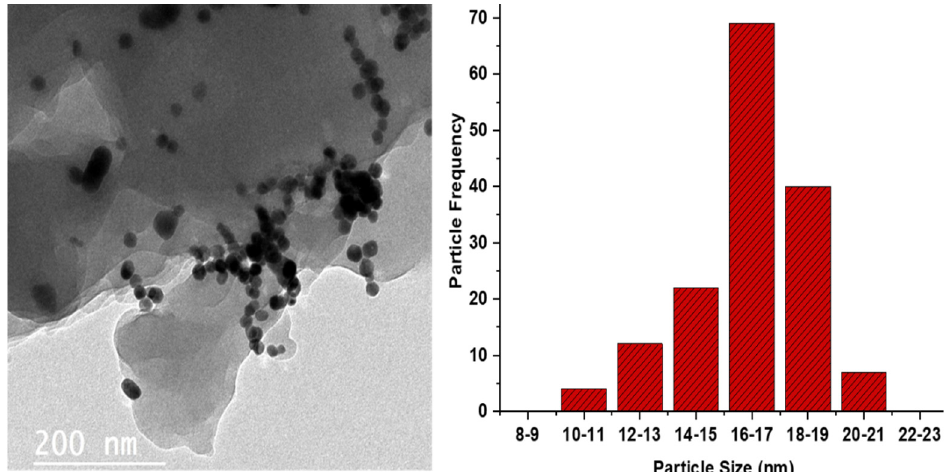
Figure 4. TEM micrographs of AgNPs synthesized by Teucrium apollinis extract as protecting and stabilized ligands. AgNP is formed in a spherical shape with a 16 ± 1.8 nm size.